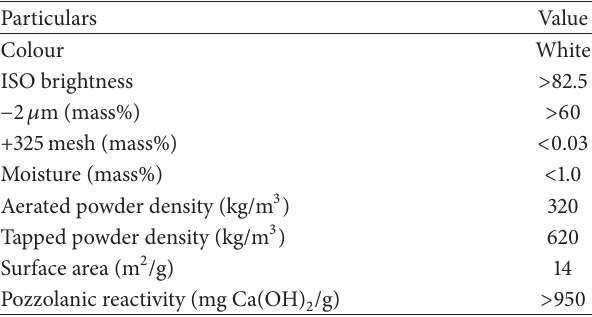
Table 2: Metakaolin